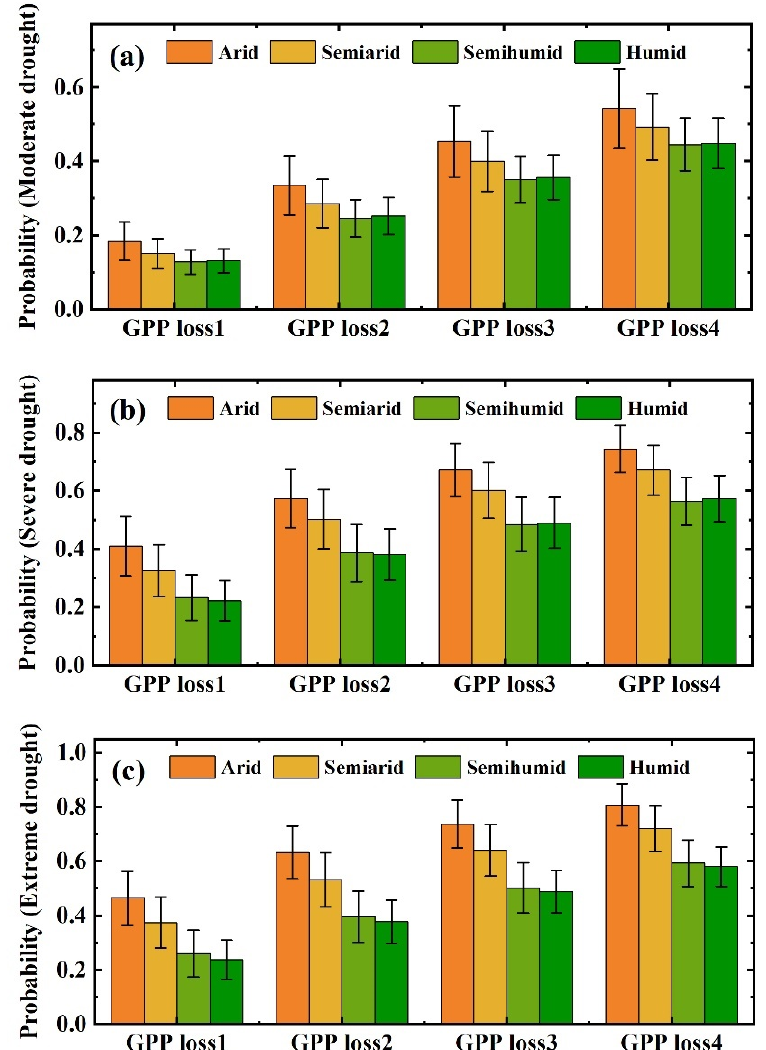
Figure 9. Conditional probabilities of vegetation productivity losses under different scenarios in various climatic regions in March–May. ( a – c ) represent conditional probabilities of vegetation productivity losses under moderate, severe and extreme drought, respectively. GPP loss1, GPP loss2, GPP loss3 and GPP loss4 represent GPP ≤ 10th, ≤ 20th, ≤ 30th, and ≤ 40th percentiles, respectively. The error bars indicate ± 1 standard error.